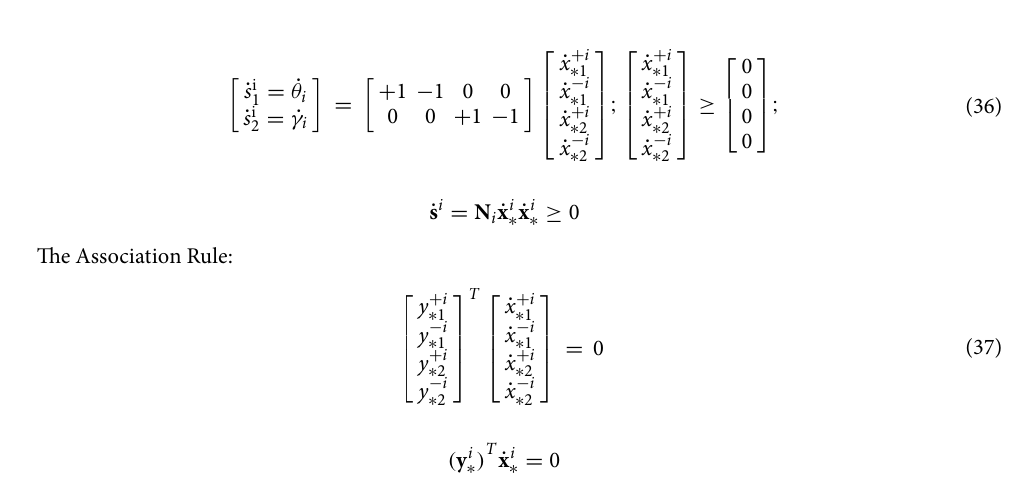
Figure 13. Rectangular yield surface showing the interaction of shear force and bending moment at shear critical